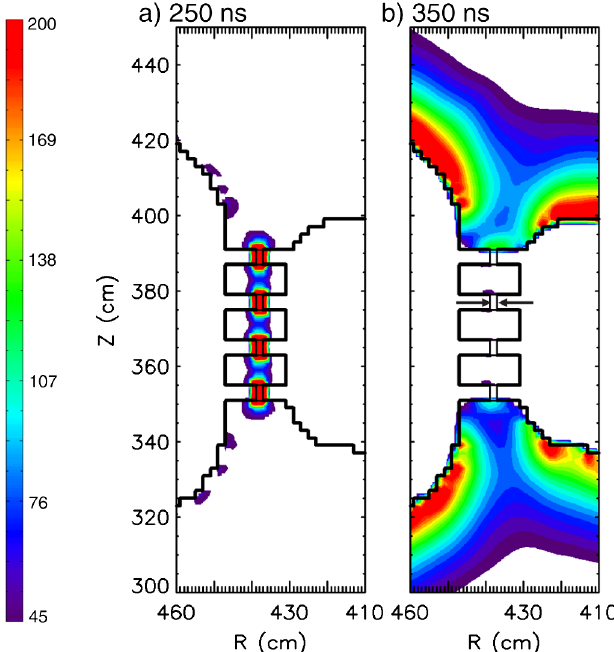
FIG. 10. (Color) Electric-field magnitude in the upper model pulse-sharpening water switches in the (cid:2) ¼ 0 plane at 250 and 350 ns. The arrows indicate the location of the conductivity channel in the